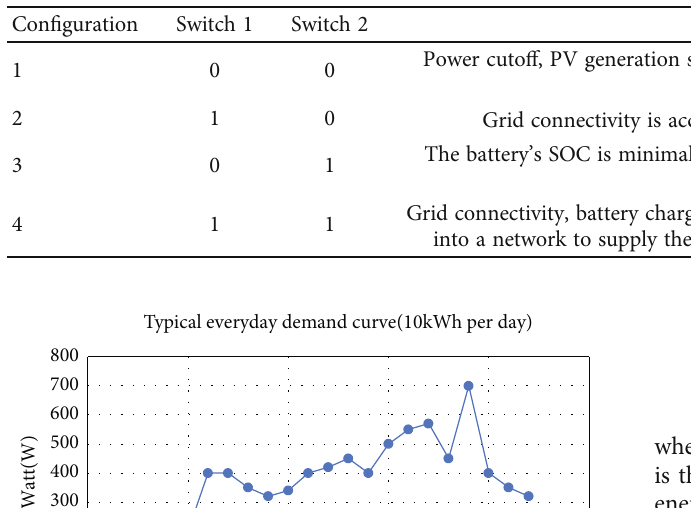
Table 3: System operating modes.